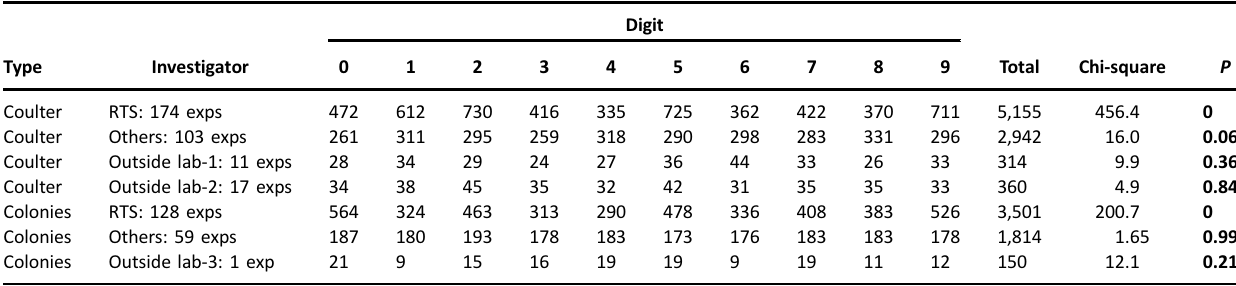
Table 3. Terminal digit analysis of Coulter and colony